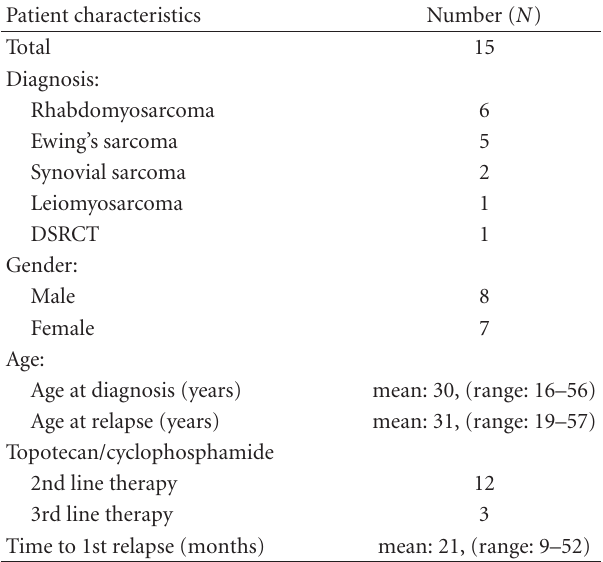
Table 1: Patient